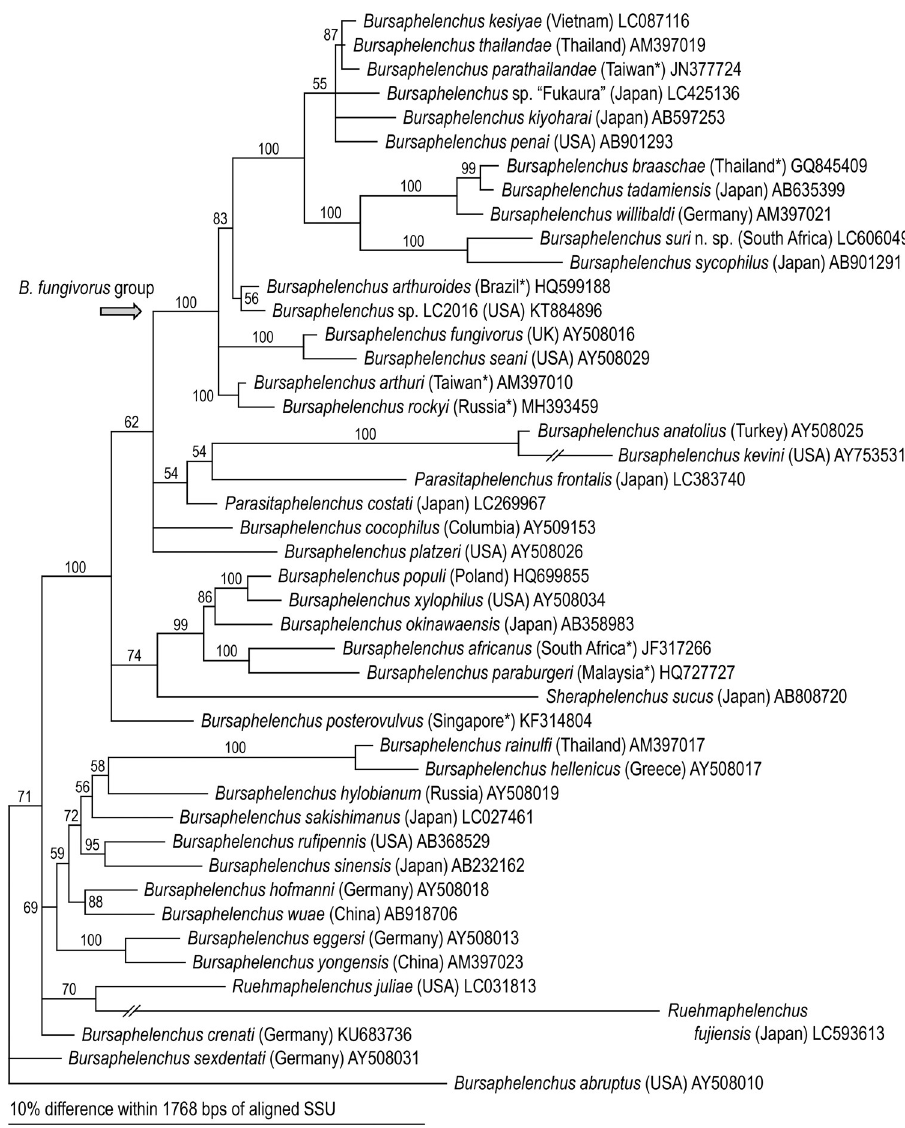
Fig 1. Bayesian tree inferred from SSU under GTR+G+I model. For model selection, AIC = 19854.013; lnL = -9829.881. Analytical parameters are: freqA = 0.26, freqC = 0.19, freqG = 0.27, freqT = 0.28; R(a) = 1.11, R(b) = 2.70, R (c) = 1.46, R(d) = 0.54, R(e) = 4.66, R(f) = 1.00; Pinva = 0.35; Shape = 0.31. Posterior probability values exceeding 50% are given on appropriate clades. The type locality of each species marked with an asterisk suggests that the material was isolated from wooden packing material imported from that